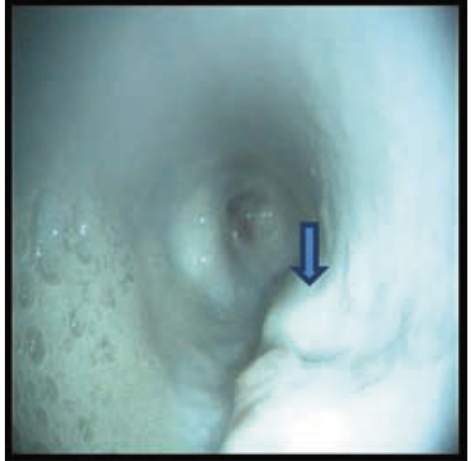
Fig. 2. Oesophageal nodules